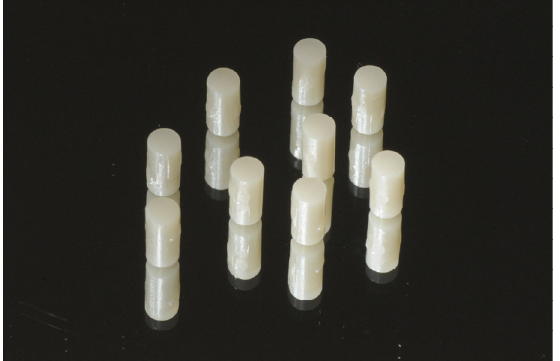
Figure 3. G-PMMA cylindrical samples.